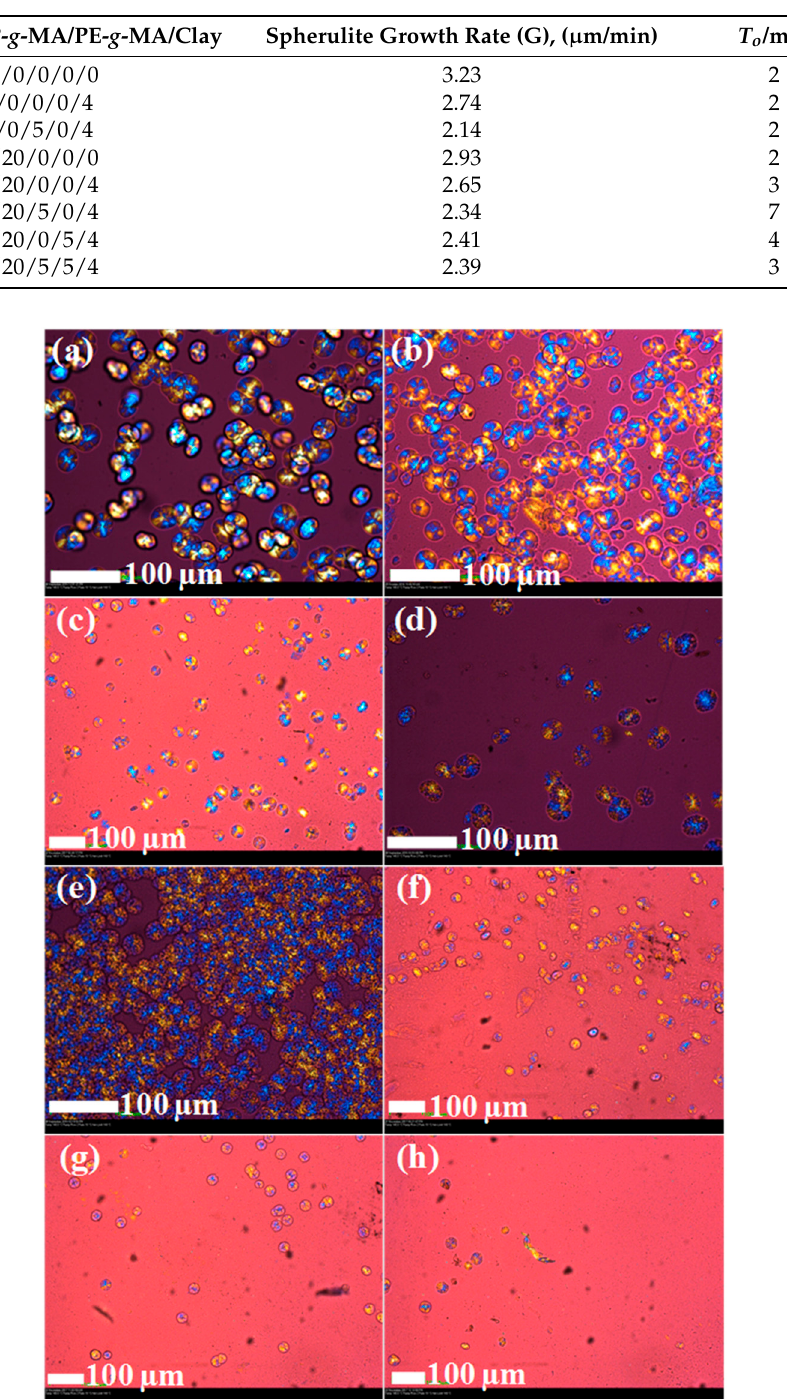
Table 5. Crystal growth rate of PP of samples isothermally crystallised at 140 ◦ C for 30 min.